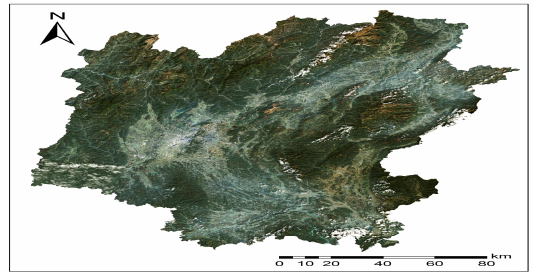
Figure 3-1 image map of Guilin City in 2016